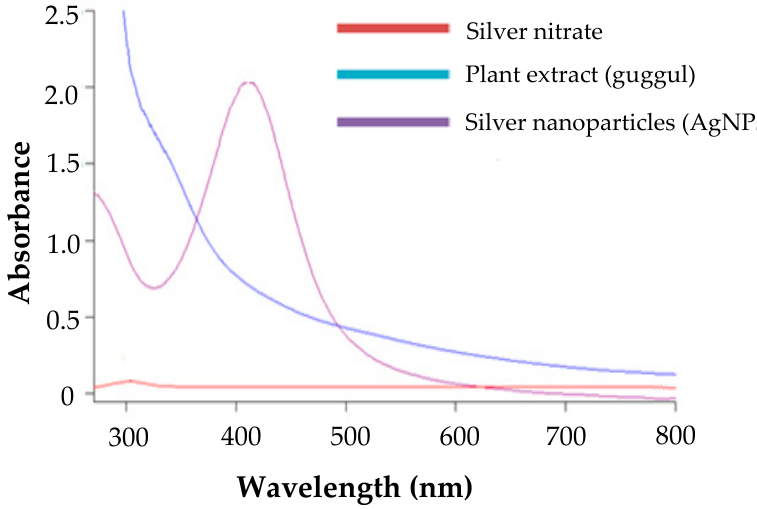
Figure 2. Surface Plasmon Resonance (SPR) depicted by UV Spectroscopy of silver nanoparticles.